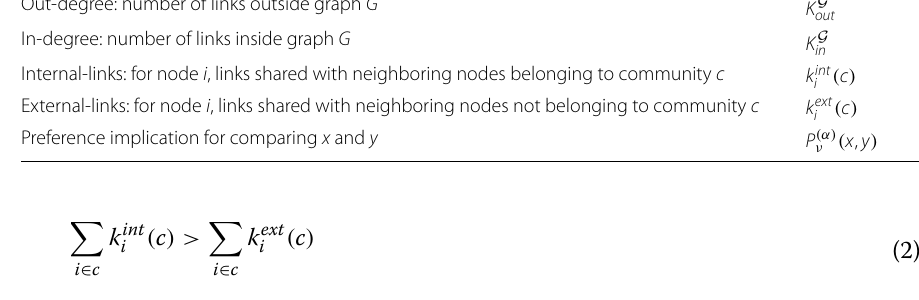
Table 1 The notations and their meaning used in the preference relation approach Meaning Abbreviation Input graph on which communities are to be detected G = ( V , E ) Out-degree: number of links outside graph G K G In-degree: number of links inside graph G K G Internal-links: for node i , links shared with neighboring nodes belonging to community c k int External-links: for node i , links shared with neighboring nodes not belonging to community c k ext Preference implication for comparing x and